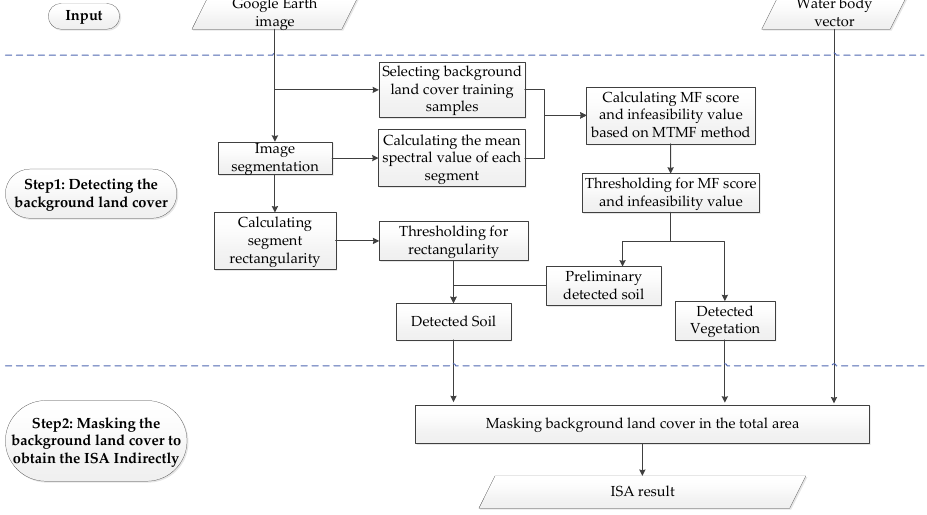
Figure 3. The framework of the proposed detecting and masking background land cover (DMBLC) approach. To deal with the high spatial and spectral variability, as well as confusion in relation to soil within ISA extraction, water body vector data, image segmentation, MTMF, and segment rectangularity are exploited to identify background land cover. This approach firstly utilizes image segmentation, MTMF, and segment rectangularity to detect vegetation and soil. Vegetation is extracted after thresholding the MF score and infeasibility values from MTMF. Soil is detected by thresholding the MF score and infeasibility values from MTMF, and segment rectangularity. Water is directly obtained by water